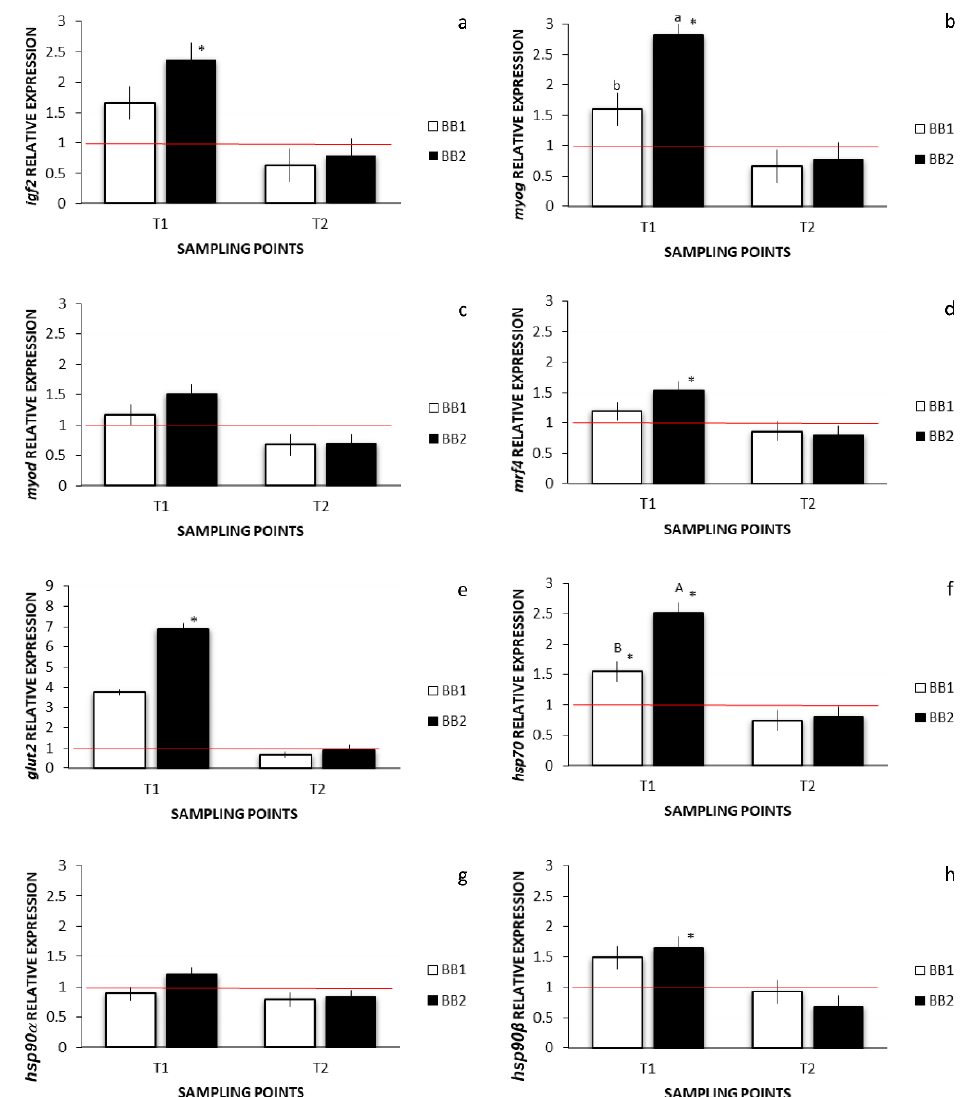
Figure 7. Relative gene expression of: ( a ) igf2; ( b ) myog ; ( c ) myod ; ( d ) mrf4 ; ( e ) glut2 ; ( f ) hsp70 ; ( g ) hsp90a ; ( h ) hsp90b ; a,b Means with different superscripts indicate significant differences of at least p < 0.05, between BB1 and BB2; A,B Means with different superscripts indicate significant differences of at least p < 0.01, between BB1 and BB2; asterisks indicate a significant difference between BB1 or BB2 and CTR, corresponding to the red line, which indicates the up- and down-regulation limit at least at p < 0.05.